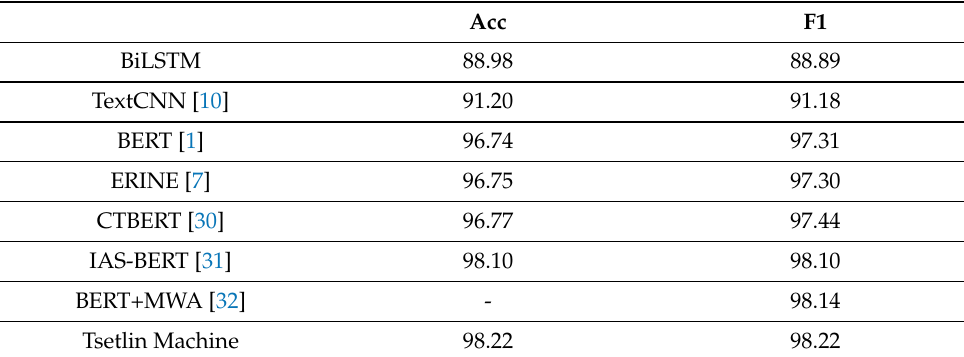
Table 2. Experimental Result in Weibo-Senti-100k.